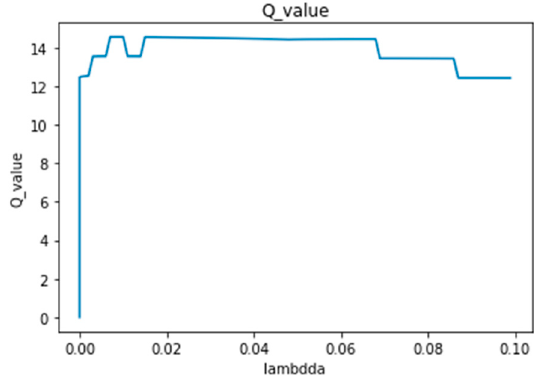
Figure 6. Target function optimization.